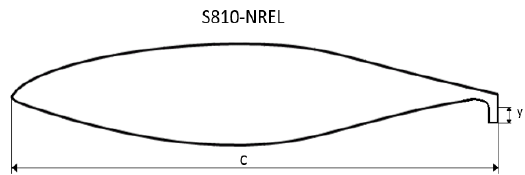
Figure 1. S810 National Renewable Energy Laboratory (NREL) aerodynamic airfoil and Gurney flap (GF) dimension.